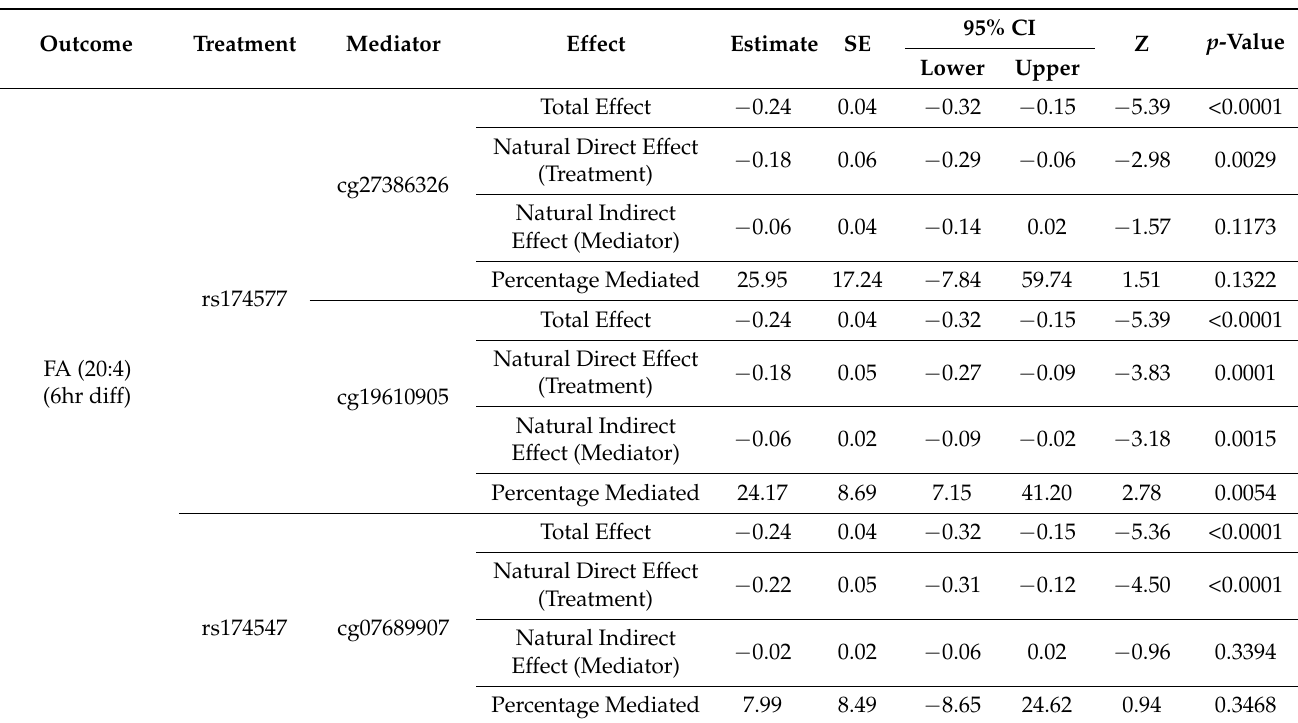
Table 4. Mediation